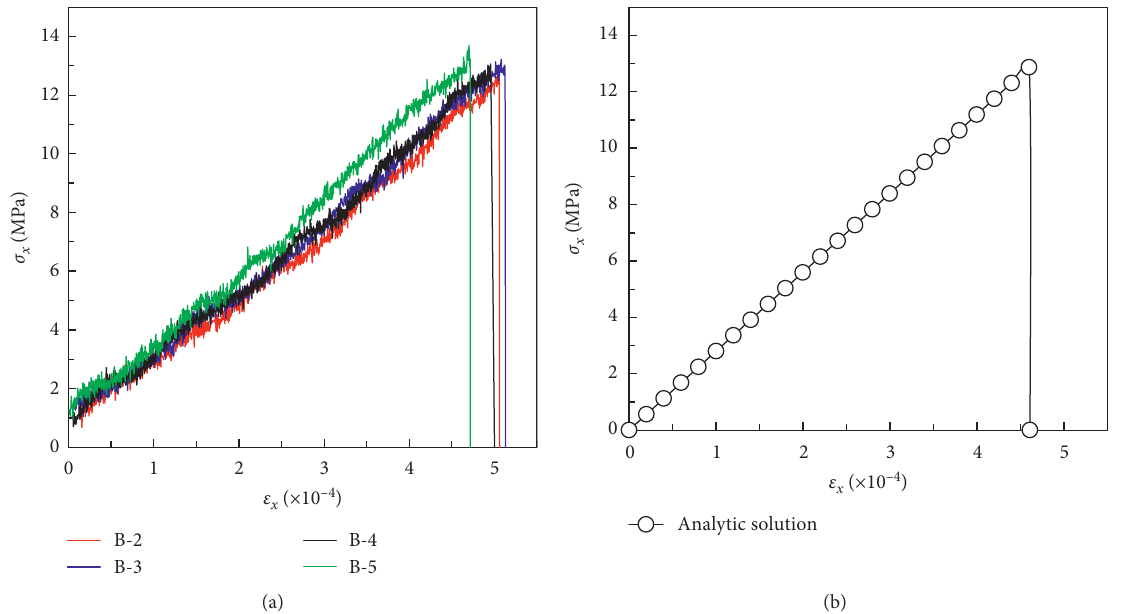
Figure 7: Measured (a) and modelled (b) stress-strain curves for four sandstone